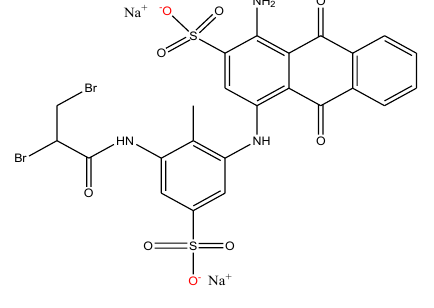
Fig. 1. Chemical structure of reactive blue 50